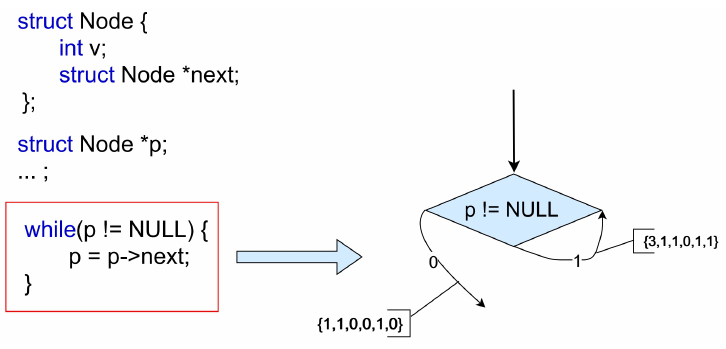
Figure 7. CFG with statement